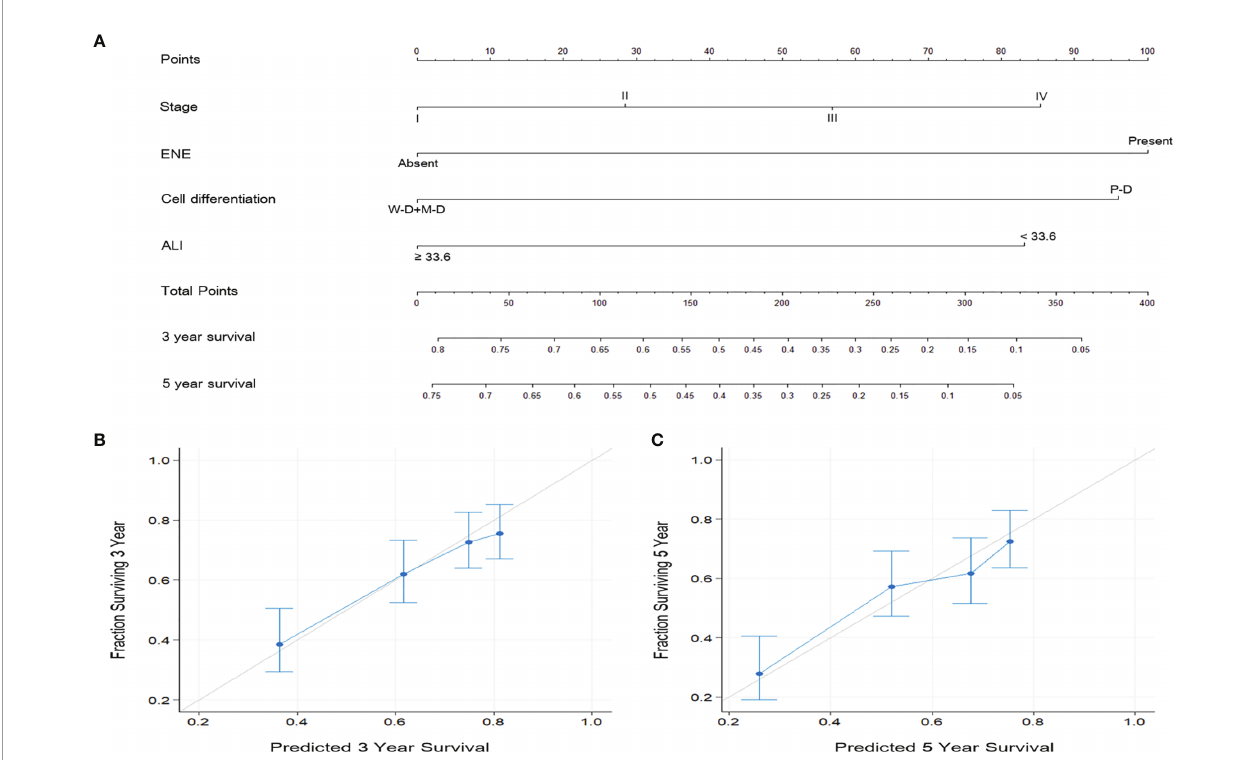
FIGURE 5 | (A) Nomogram based on ALI and independent prognostic factors for DFS prediction. (B, C) Calibration plots of the nomogram for (B) 3-year and (C) 5-year DFS prediction. The predicted values were in good agreement with the observed